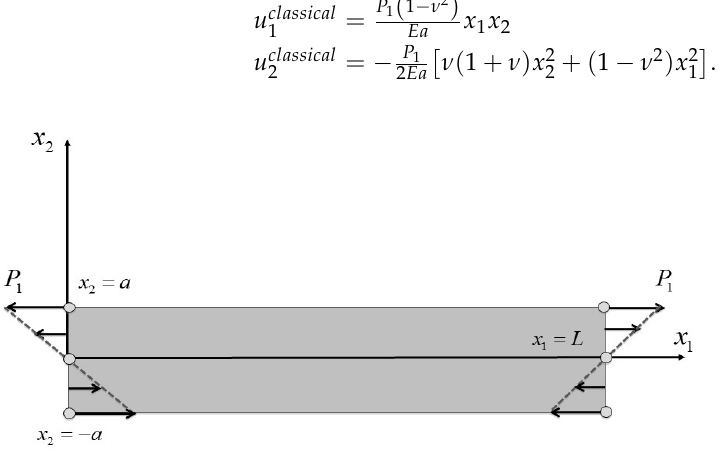
Figure 1. Pure bending of an elastic beam.